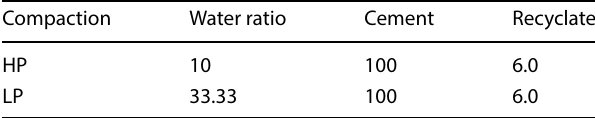
Table 2 Mixture proportions of cement powder (wt%)